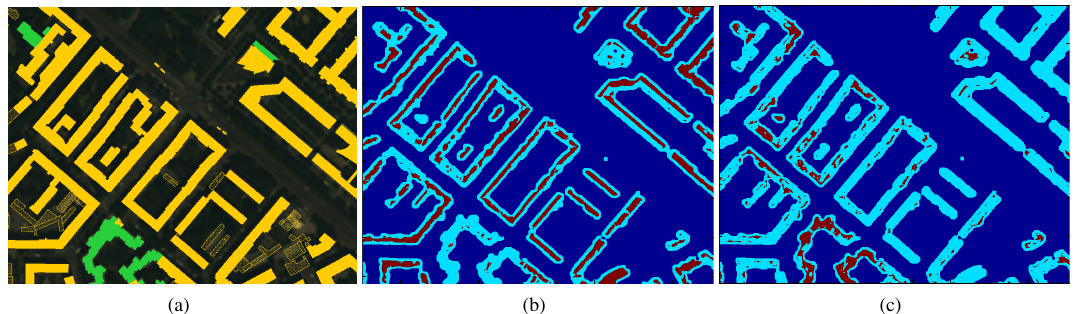
Figure 5: The ground truth (a), and demonstration of the areas in image I detected as pitched (b) and flat (c) roofs. In the ground truth pitched and flat roofs are depicted by yellow and green, respectively Image Performance measure